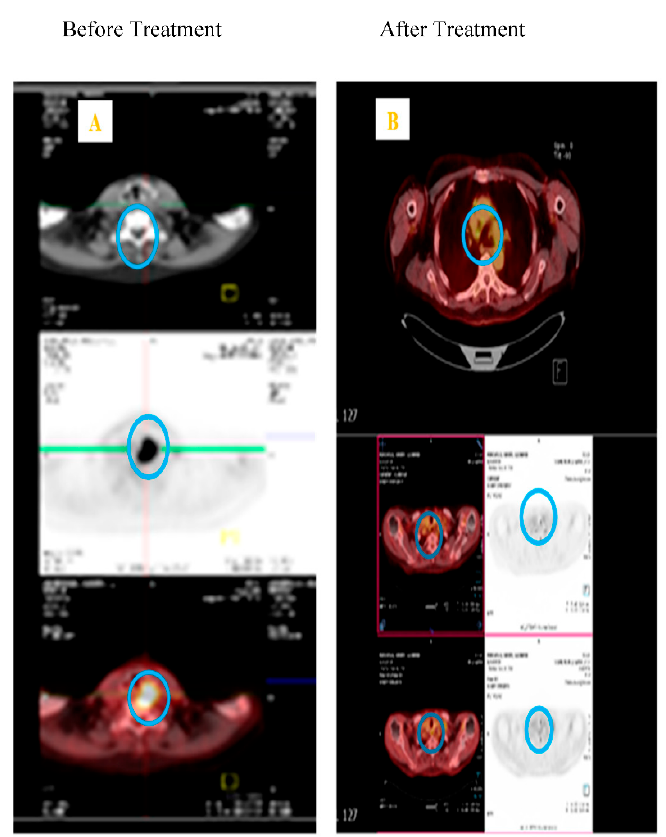
Figure 2. CT scans of the neck region in pyriform fossa squamous cell carcinoma patient showing the tumour area and no local recurrence. ( A ) Right panel blue circle showing clear palpable lymphadenopathy. ( B ) Left panel blue circle showing the tumour regression after two years, nasendoscopy also showed no local recurrence.